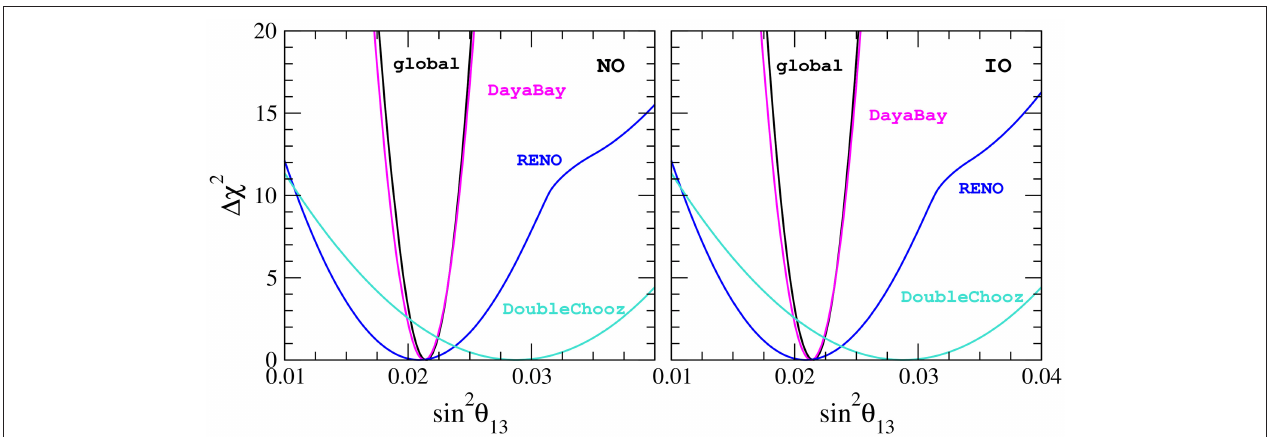
FIGURE 2 | 1χ 2 profile as a function of sin 2 θ 13 from the analysis of global neutrino data (black line), as well as from the separate analysis of the reactor experiments: Daya Bay (magenta), RENO (blue) and Double Chooz (turquoise). Left ( Right ) panel corresponds to normal (inverted) mass ordering. Figure adapted from de Salas et al. [